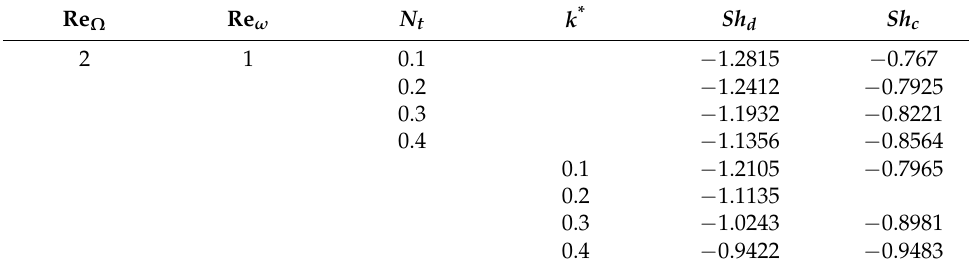
Table 5. Effects of Re Ω , Re ω , N t , and k ∗ on Sh d and Sh c . Re Ω Re ω N